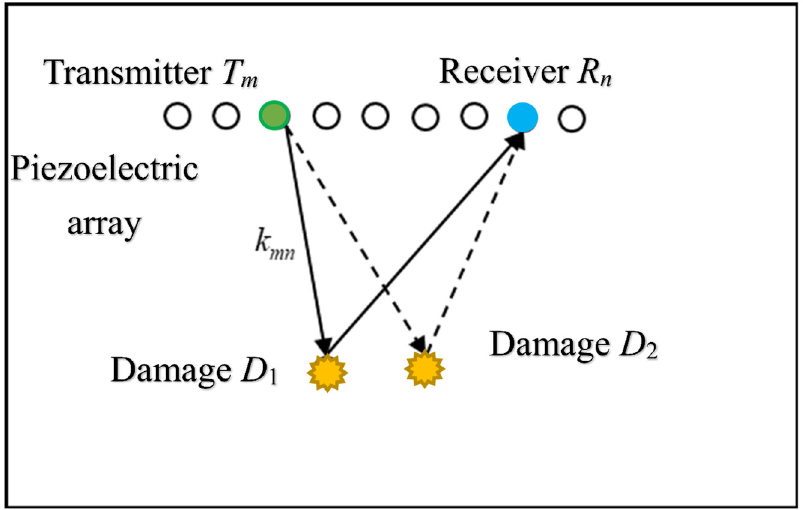
Figure 1. Piezoelectric array and transfer matrix.